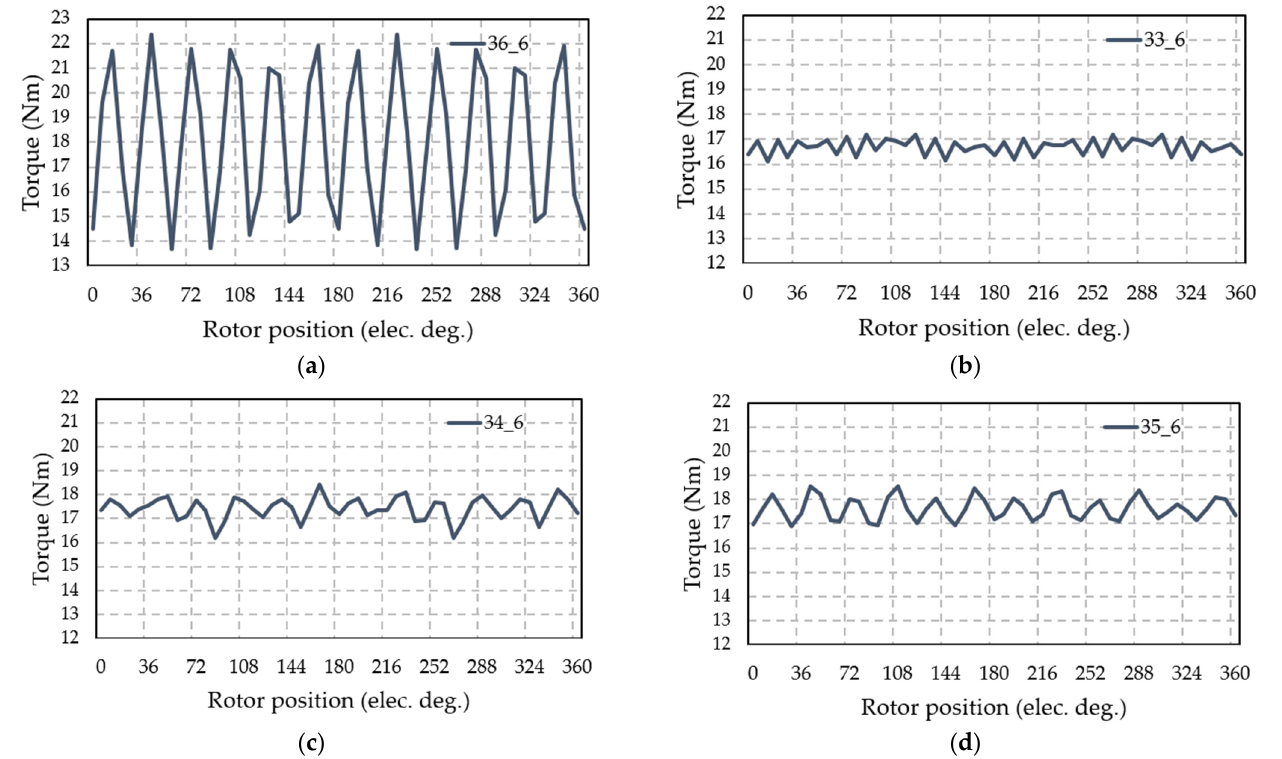
Figure 9. Torque waveforms of four motors with two − layer flux barrier and PM: ( a ) M 1 : 36 − slot and 6 − pole; ( b ) M 2 : 33 − slot and 6 − pole; ( c ) M 3 : 34 − slot and 6 − pole; ( d ) M 4 : 35 − slot and 6 − pole.